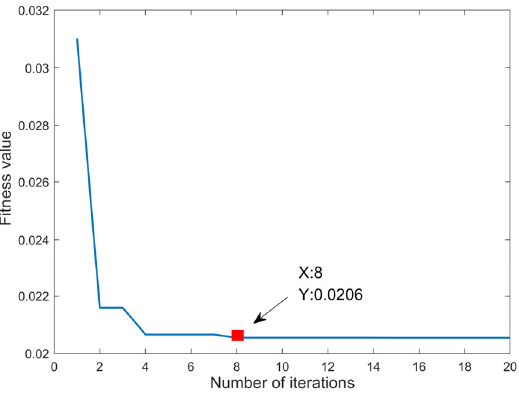
Figure 8. DA convergence curve for VMD parameter optimization.